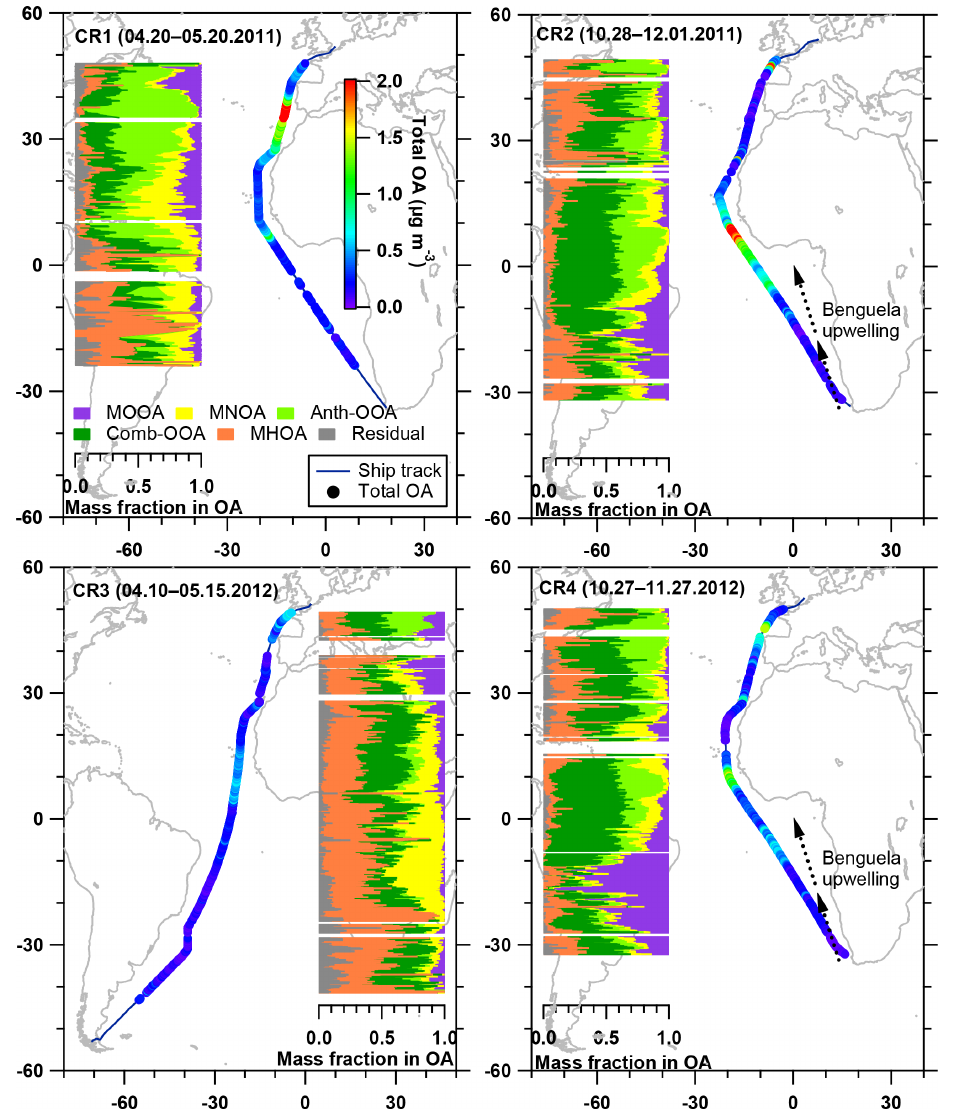
Figure 5. Latitudinal distribution of five OA factor mass fractions in the total OA, with total OA mass concentration along the ship track during four cruises. The Benguela upwelling is marked in the maps for CR2 and CR4, while it is not displayed (but still exists) in CR1 and